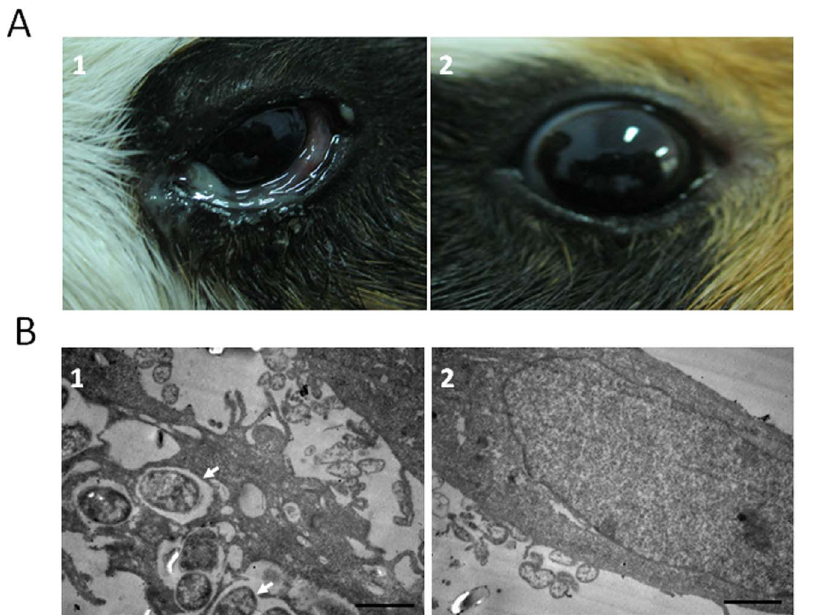
Figure 1. The virulence of the human Shigella strain ZD02 using the Sereny test and the HeLa cell invasiveness test. (A) Sereny test. Guinea pigs were infected with Shigella strain ZD02 via the cornea and conjunctiva. Corneal and conjunctiva inflammation were seen in infected eyes at 18 h post-inoculation (A1). Corneas and conjunctiva is normal in uninfected control eyes (A2). (B) HeLa cells infected with the Shigella strain ZD02. Transmission electron microscopy was used to detect the internalized bacteria within HeLa cells. Representative pictures are shown. The internalized bacteria (arrowheads) were detected at 2 h post-inoculation (B1). Control HeLa cells without infection (B2). Scale bars=1 m m.